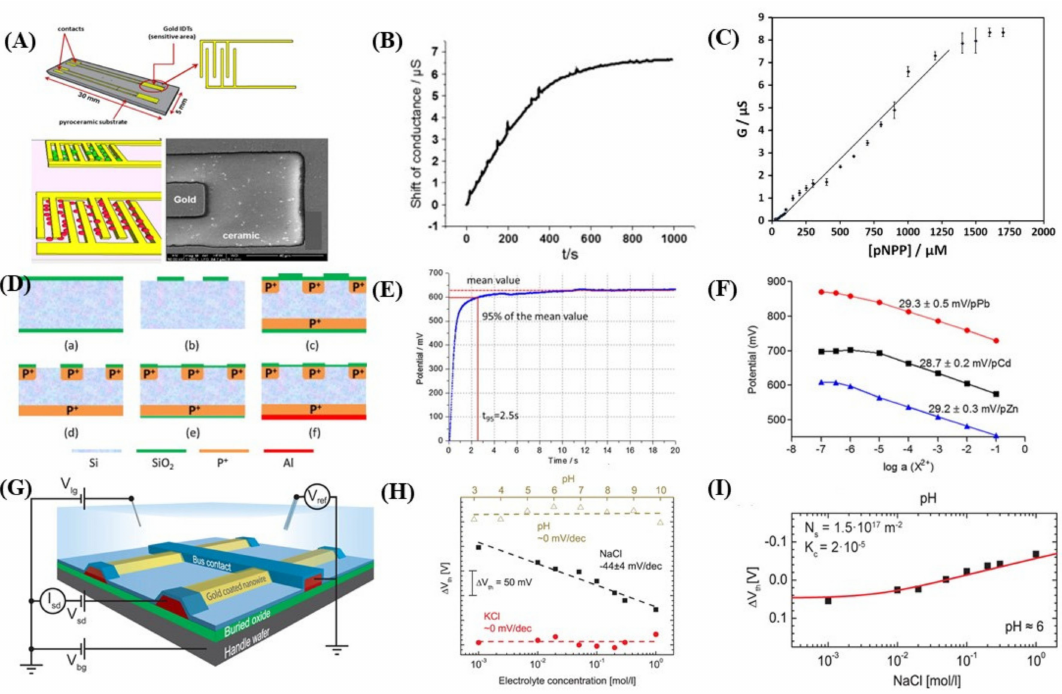
Figure 3. ( A ) Schematic of the microelectrodes with the gold electrode, the working electrode is im- mobilized with Spirulina cells, the reference electrode is immobilized with inhibited APA, which also includes Spirulina cells, and S.E.M. image of spirula cells with the gold electrodes of interdigitated transducers. ( B ) The real-time response of the conductometric transducer. ( C ) Standard calibra- tion curve for the detection of the alkaline phosphatase activity (reproduced with the permission from [119]). ( D ) Fabrication process. ( E ) the response time of the sample solution. ( F ) The averaged calibration curve (reproduced with the permission from [123]). ( G ) Schematics of the measurement setup of the FET sensor. ( H ) Differential threshold voltage ( ∆ V th ) measurement of the gold-coated NWs vs concentration of the electrolyte and pH. ( I ) Response of the ionic strength of the gold-coated NW fitted with a blended site-binding model for deprotonation, protonation, and Cl– adsorption (reproduced with the permission from